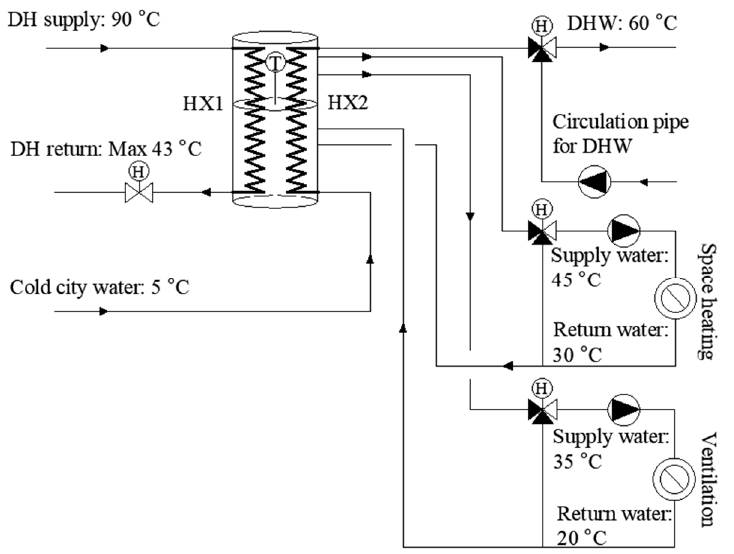
Figure 3. System connection and temperatures with short-term thermal energy storage in design conditions (Substation 2). conditions (Substation